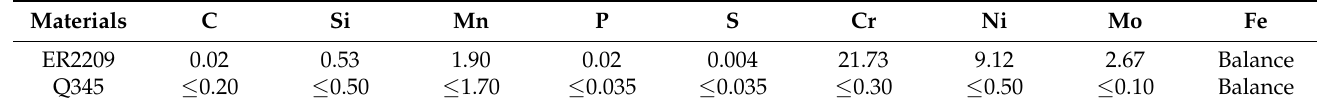
Table 1. Chemical compositions of wire and base